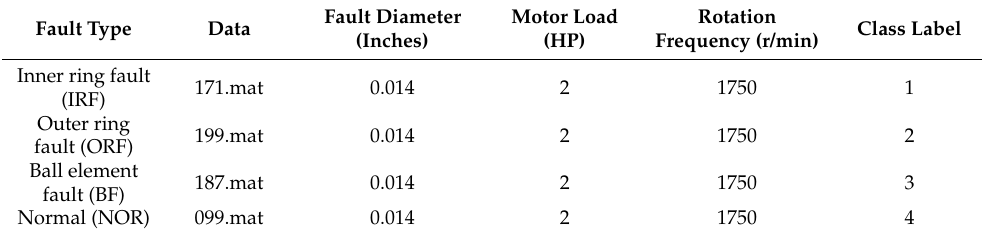
Table 3. Description of experimental